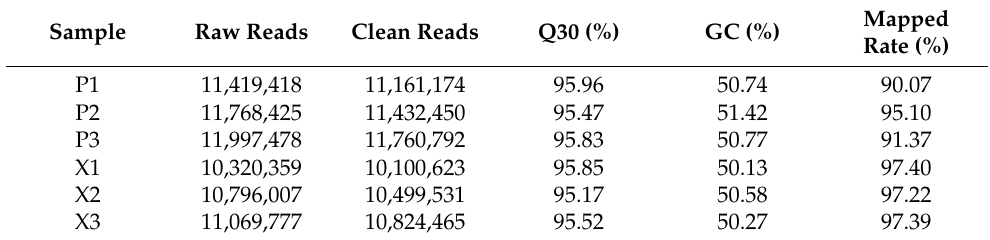
Table 1. Summary of sRNA